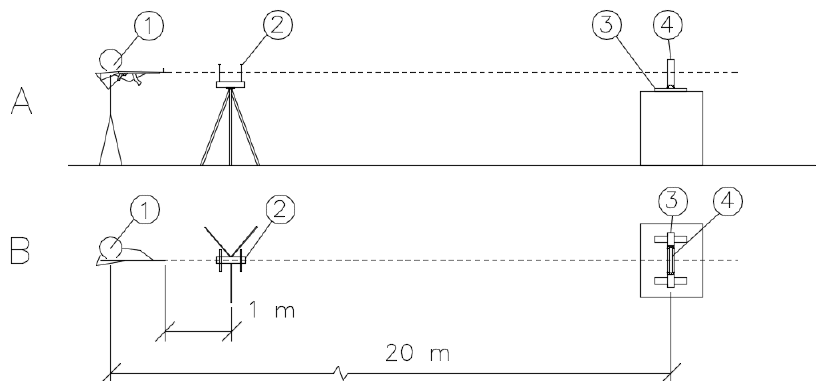
Figure 3. The layout of the experiment: ( A ) side view and ( B ) plan view. 1. Shooter, 2. Velocity gates, 3. Sample mounting frame, 4. Sample.